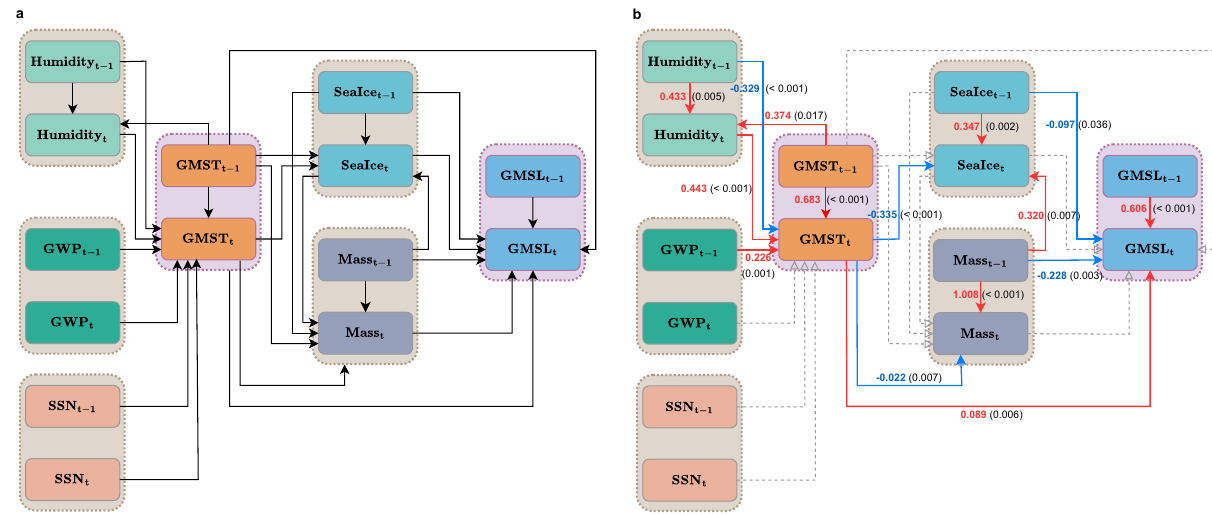
Figure 2. ( a ) Full hypothesized unified structural equation model (uSEM), and ( b ) the confirmed uSEM with significant pathways selected in unison by two variable selection methods—the system-wise regularized uSEM (RuSEM) approach and the equation-wise stepwise variable selection based on each ARDL model. Climate Factors included (from left top to right bottom) are: Global Specific Humidity (Humidity), Global Warming Potential (GWP), Sunspot Number (SSN), Global Mean Surface Temperature with sea ice area measured by air above sea ice (GMST), Arctic Sea Ice August Extent (Sea Ice), Glaciers and Ice Sheets Mass Balance (Mass), and Global Mean Sea Level (GMSL). In ( a ), the full hypothesized path model with all conceivable directed paths not contradictory to common sense as depicted by the black arrows. In ( b ), the final path model identified, significant positive or negative pathways are labeled with red or blue arrows with the corresponding path coefficients and p-values (in parentheses, 1-sided) labeled, while grey dashed arrows represent insignificant pathways at the significant level of 0.05